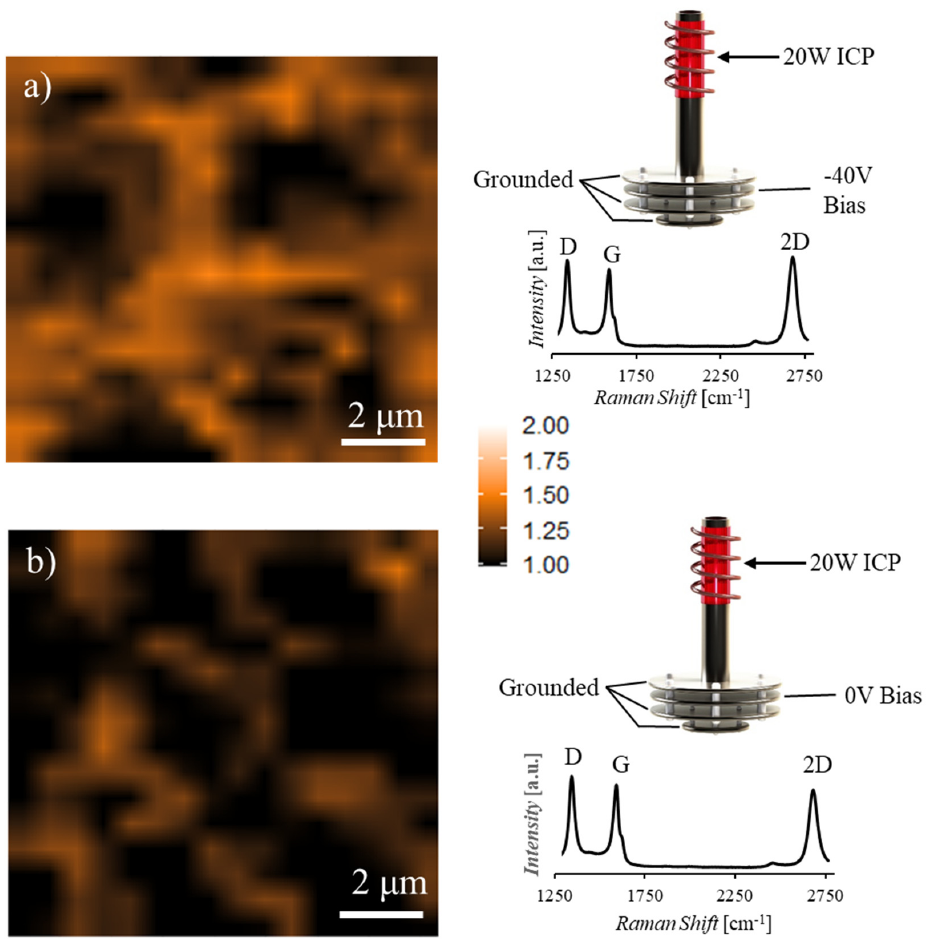
Figure 3. Ion screening bias effects on graphene film layer number. 100 μ m 2 Raman I 2D/G maps and accompanying average Raman spectrum over the mapped area for graphene samples synthesized